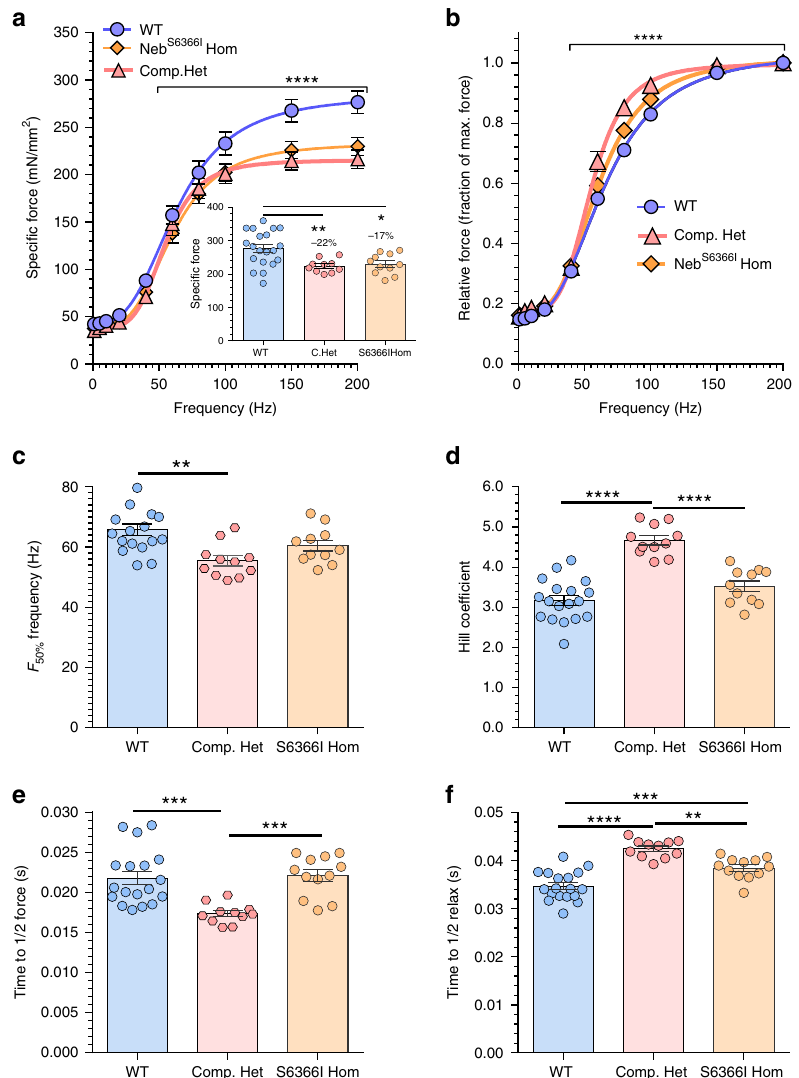
Fig. 6 Muscle mechanics. a Force-frequency relation of WT, Compound-Het and S6366I Hom EDL muscle. Inset shows maximal force (200 Hz stimulation rate). Force is reduced in Compound-Het and S6366I Hom mice. (Force expressed as speci fi c force: force per unit area of muscle, mN/mm 2 ). * p = 0.013, ** p = 0.007. b Relative force-frequency shows steeper force rise in Compound-Het mice. c Frequency for 50% force (F 50% ) is reduced in Compound-Het mice. ** p = 0.0012. d Hill coef fi cient is increased in Compound-Het mice. **** p < 0.0001. e Time to 1/2 maximal force of 200 Hz tetanus is reduced in Compound-Het mice. *** p = 0.0005. f Time to 1/2 relaxation of 200 Hz tetanus is increased in Compound-Het mice and S6366I Hom mice. ** p = 0.002, *** p = 0.0008 and **** p < 0.0001. a – f : n (WT) = 20 mice; n (Compound-Het) = 11 mice; n (S6366I Hom) = 11 mice. Bar values are mean ± SEM. a , b Non- linear least squares fi t to Hill curve with as null hypothesis that one curve fi ts all data sets. Test (Sum-of-squares F-test) reveals that the null hypothesis is rejected in each panel ( p ≤ 0.0001, F (DFn, DFd) 9.633 (8,408)). a inset and c – f : ordinary one-way ANOVA without matching or paring. A posthoc multiple testing comparison with multiple testing correction (Tukey) was performed. Source data are provided as a Source Data fi